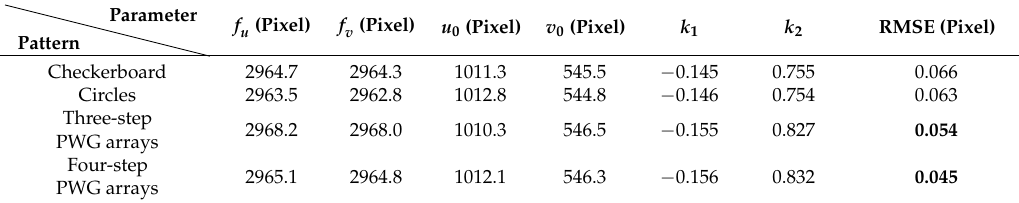
Figure 6. Re-projection errors of different patterns. ( a ) Checkerboard; ( b ) circles; ( c ) three-step PWG arrays; and, ( d ) four-step PWG arrays. Table 1. Camera intrinsic parameters estimated from different patterns.